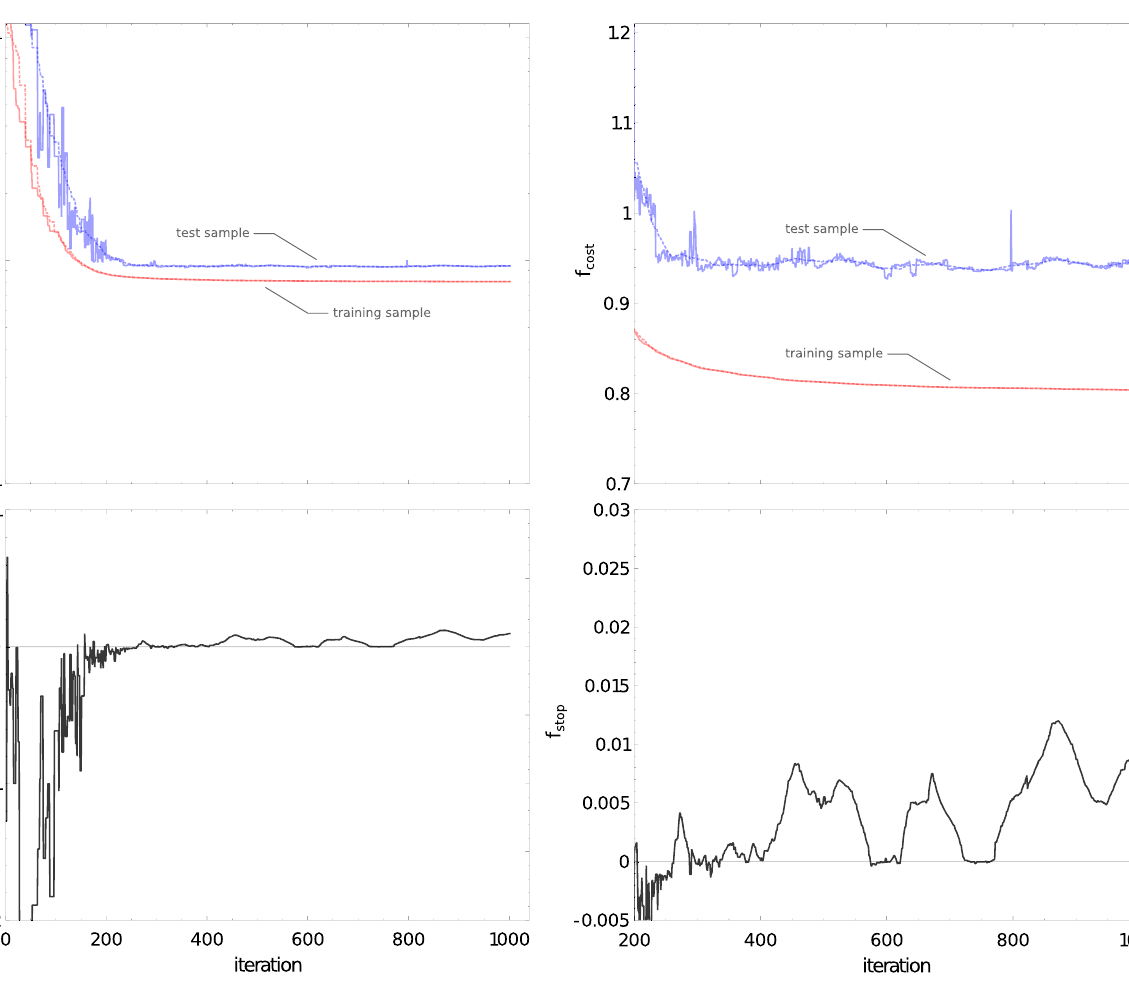
the right ones are for a zoom in the range of 200 < t < 1000. The red (blue) solid and dashed curves illustrate the values of the cost function for the training (test) sample, before and after averaging,